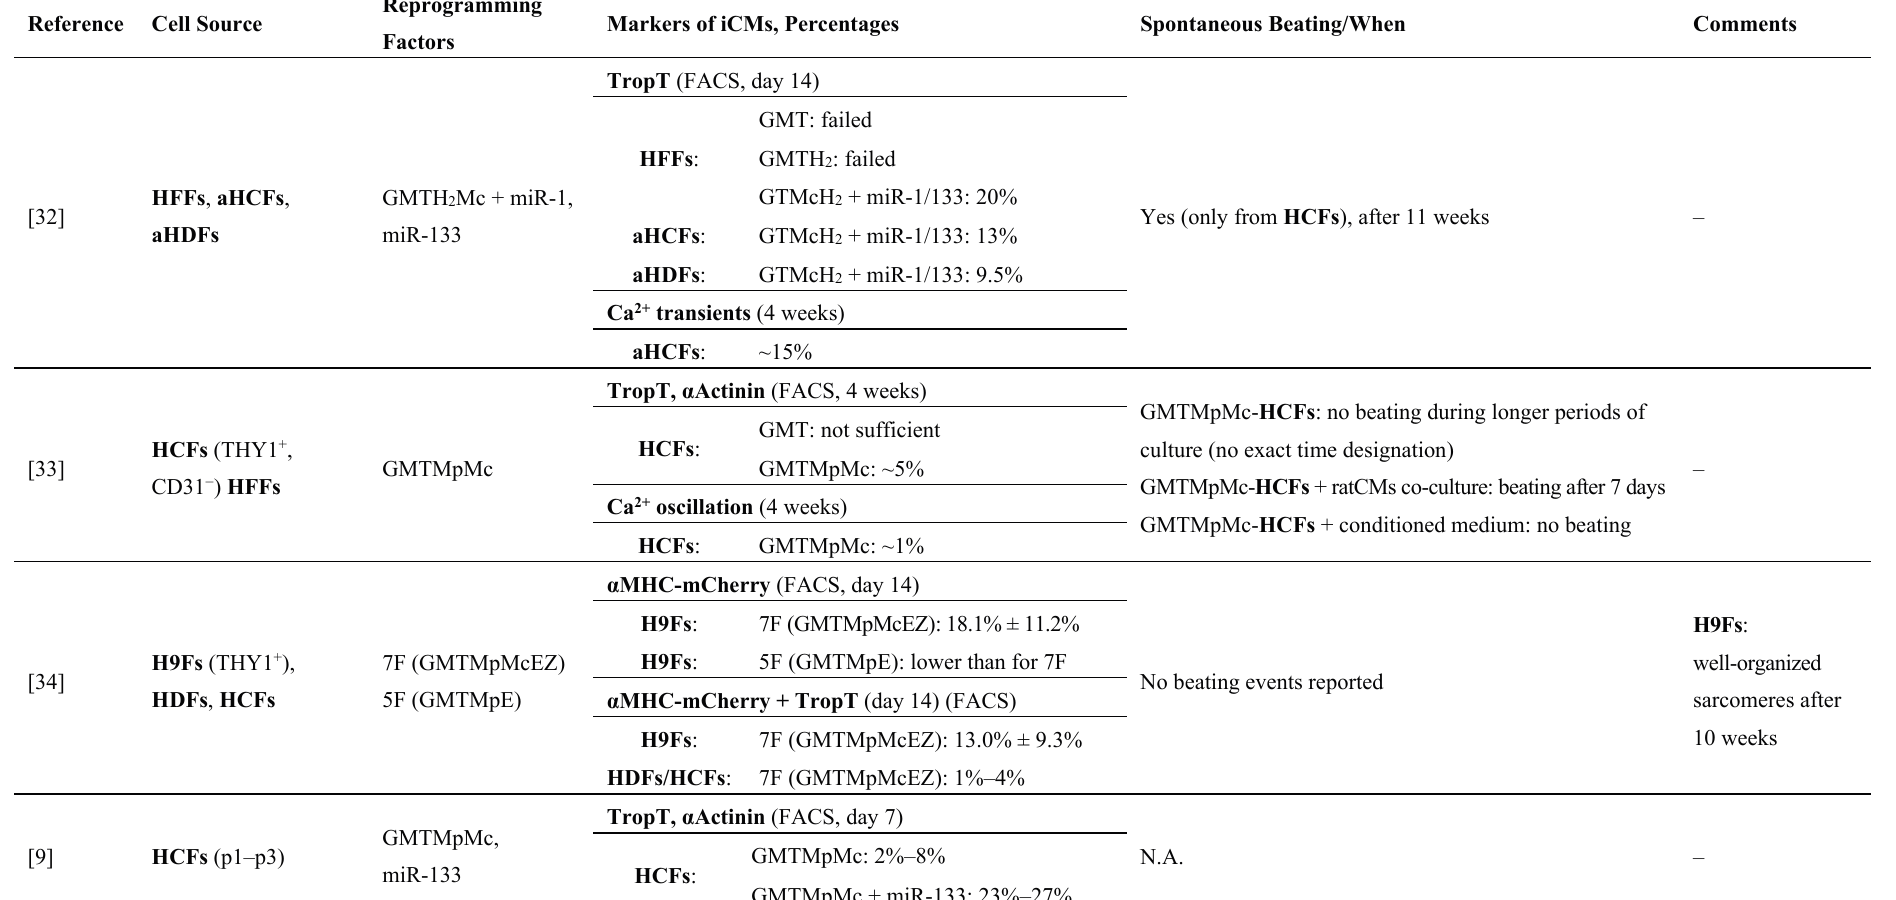
Table 2. Direct cardiac reprogramming in vitro